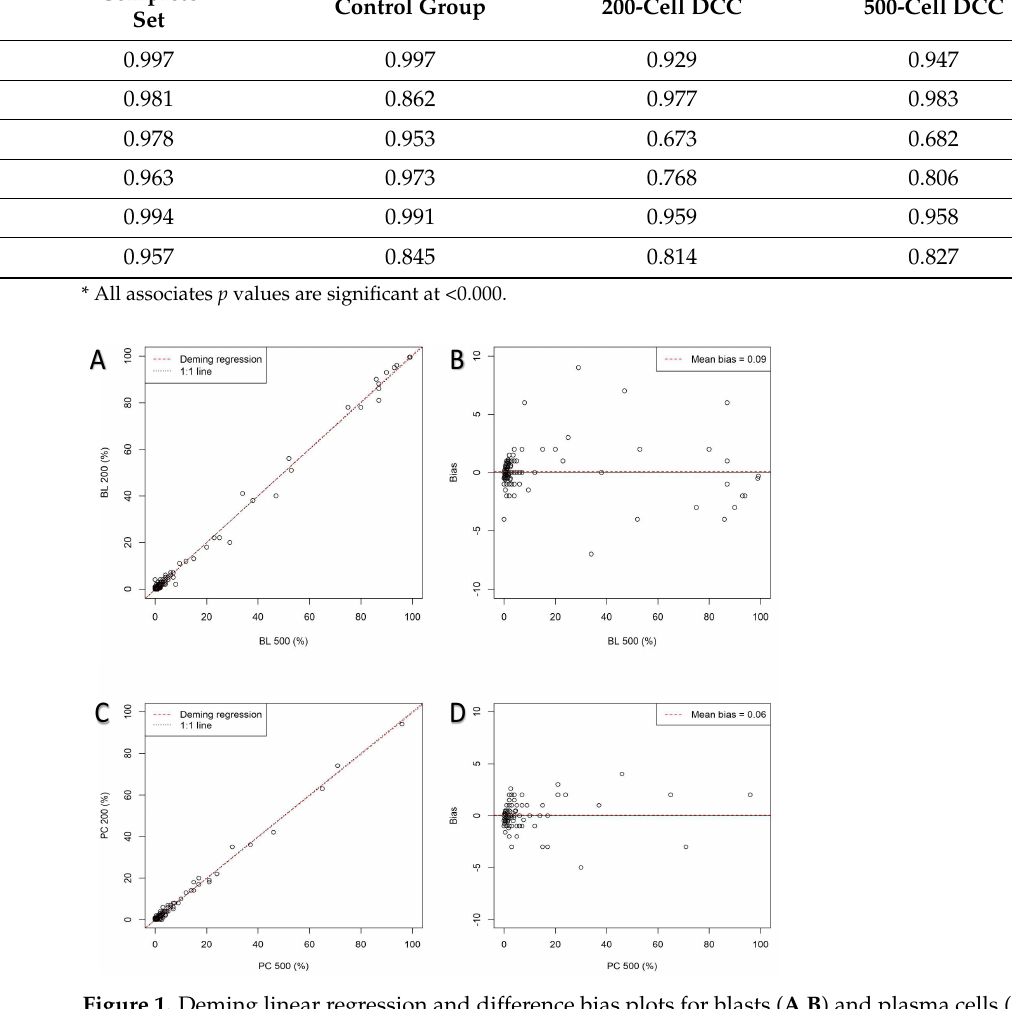
Figure 1. Deming linear regression and difference bias plots for blasts ( A , B ) and plasma cells ( C , D ). The diagnostic performance of 200-cell vs 500-cell DCC (gold standard) for BL is shown in Tables 6–8. At 20% cutoff, the 500-cell DCC identified 20 of 550 cases with ≥ 20% blasts, whereas the 200-cell DCC detected 19 of them with ≥ 20% blasts and one case with <20%. The single discrepant case was a new myelomonocytic AML in which 18% and 20% blasts were detected by 200-cell and 500-cell DCC, respectively. In addition to blasts, more than 40% of the CE corresponded to monocytic lineage, both mature and precursor cells. Therefore, this minimal blast discrepancy count was not potentially correlated with a diagnostic discrepancy. In the same way, at 10% cutoff, 22 cases showed ≥ 10% blasts with both cutoffs and only one discrepant case had ≥ 10% (11%) blasts with 200-cell and <10% (9.5%) with 500-cell count. This patient had a de novo myelodysplastic syndrome (MDS), refractory anemia with excess blasts type 2. Finally, at 5% cutoff, among 30 cases with ≥ 5% blasts according with 500-cell DCC, 28 of them also had ≥ 5% blasts with 200-cell DCC whereas two cases had <5%. Both discrepant patients had de novo MDS, with 5%